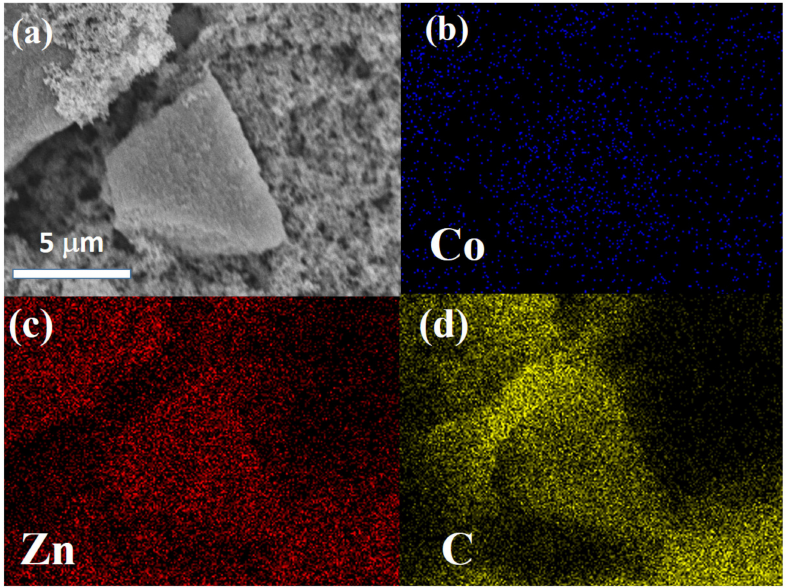
Figure 4. ( a ) SEM and EDS mapping of ( b ) Co, ( c ) Zn, and ( d ) C of Co@ZnO-NC. Figure 5a,b presented the nitrogen adsorption/desorption isotherms and pore size distributions of as-synthesized Co/ZnO-NC and Co@ZnO-NC composites. As indicated in Figure 5a, the Co/ZnO-NC sample had typical type IV features with a distinct hysteresis loop at a high P/P 0 of 0.4–1.0. The average pore size of Co/ZnO-NC composite was 3.87 nm. The average pore size of Co@ZnO-NC was 3.04 nm, and the specific surface area was 177.03 m 2 /g. These findings indicated the existence of many micropores and mesopores in these materials. The specific surface area of Co/ZnO-NC was 350.53 m 2 /g; it had a larger specific surface area and more mesopores than Co@ZnO-NC. The large specific surface area of the mesoporous structure was conducive to adaption to volumetric changes caused by Li ion extraction and insertion; therefore, the Co/ZnO-NC composite may provide more active sites for lithium storage compared with the Co@ZnO-NC